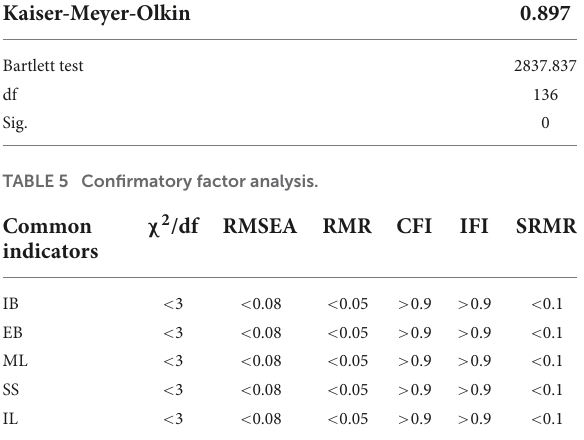
TABLE 4 KMO and Bartlett test.